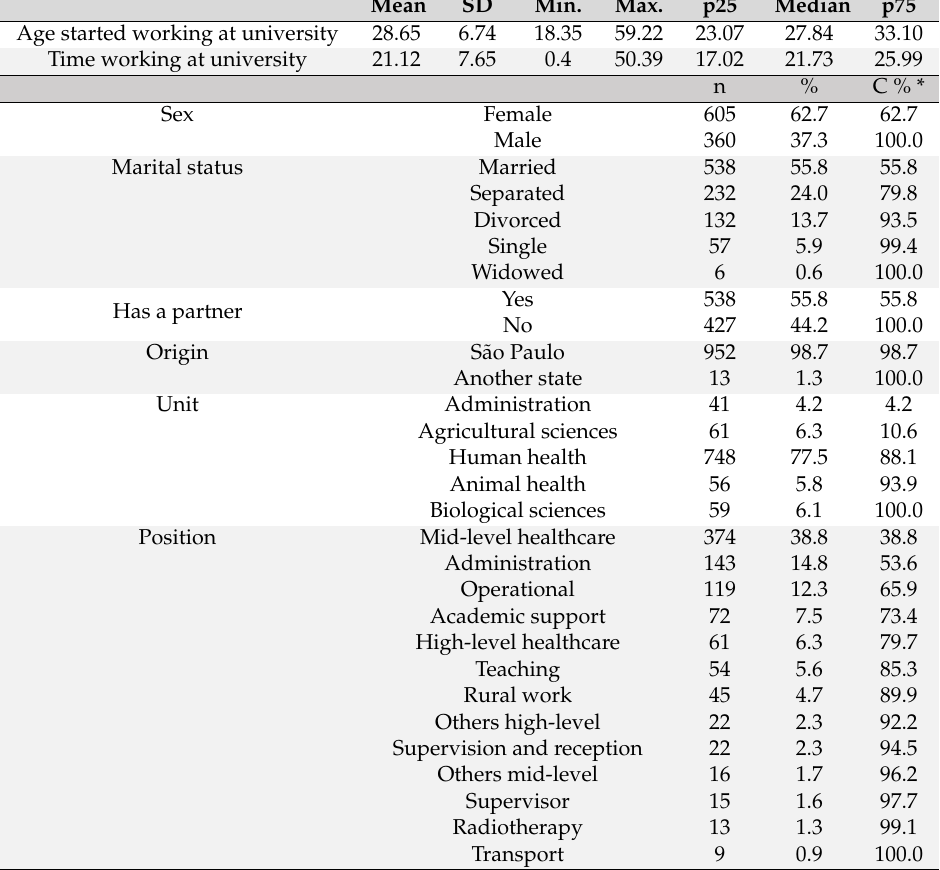
Table 1. Sociodemographic and working characteristics of the study population (n = 965). Mean SD